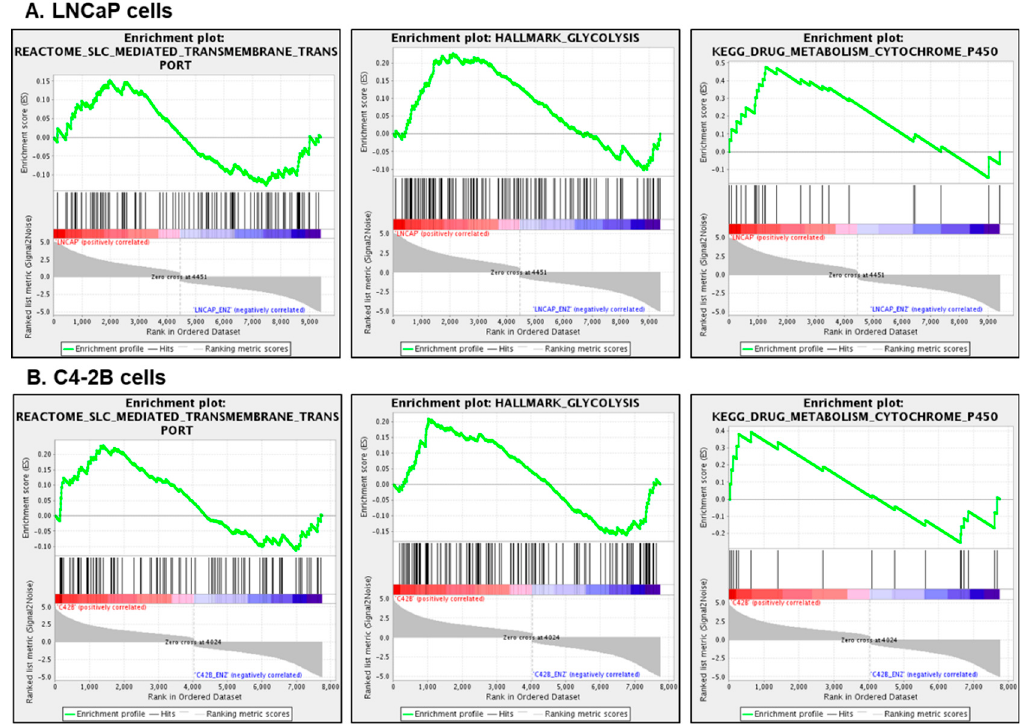
Figure 4. Gene set enrichment analysis. ( A ) LNCaP enzalutamide resistant cells and ( B ) C4-2B enzalutamide resistant cells, compared to their parental counterparts at a threshold of FDR p -value < 0.05. Enriched pathway includes SLC-mediated transmembrane transport, glycolysis, and drug metabolism. The green curve corresponds to the enrichment score (ES), which is the running sum of the weighted enrichment score obtained from GSEA software. Red and blue color bar display the positive and negative regulated genes.